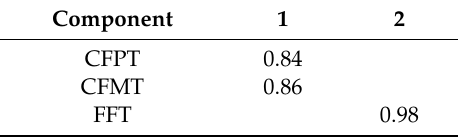
Table 4. Varimax rotated component loadings for the entire self-referred DP group’s ( N = 165) performance on the CFPT, CFMT and famous face test (FFT).